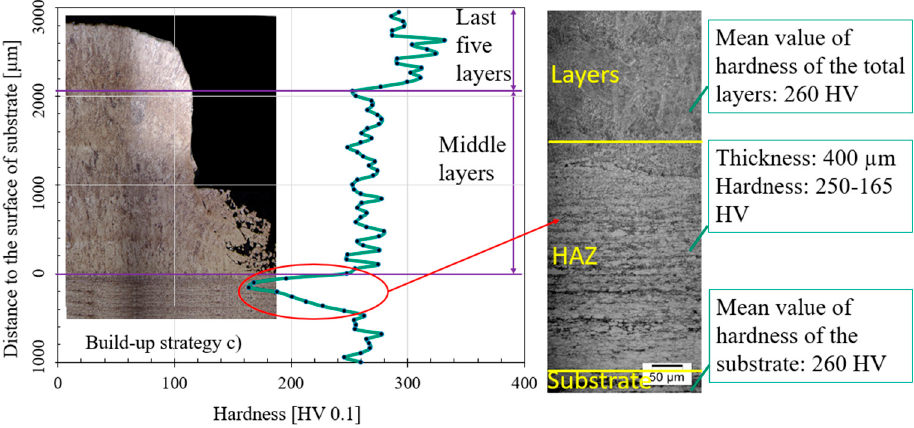
Figure 17. Hardness distribution and its corresponding light microscope photography for strategy c: Five layers as a set.